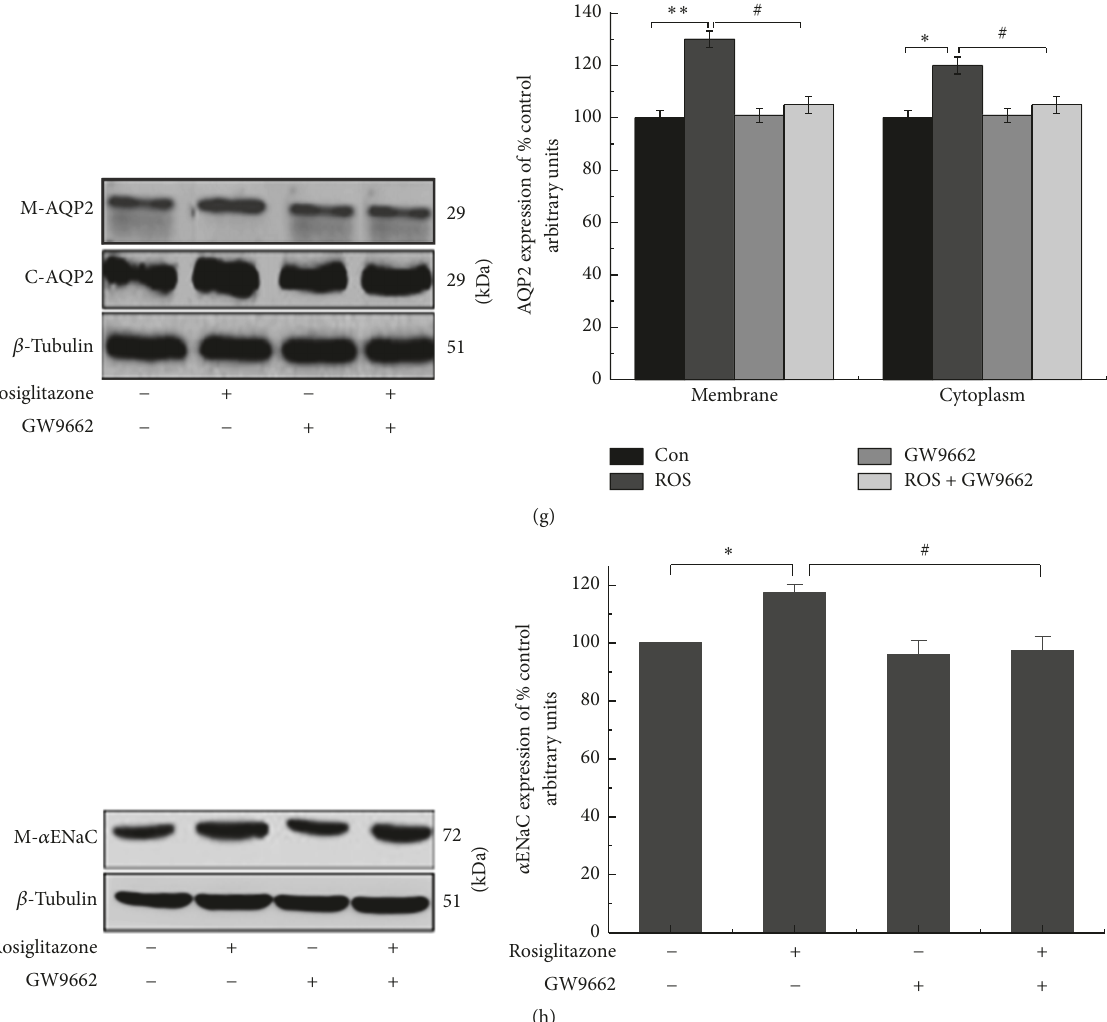
Figure 3: Effects of rosiglitazone and coincubation with GW9662 in HEK293 cells. (a–d) The effects of rosiglitazone on PPAR 𝛾 , p-PPAR 𝛾 , AQP2, and 𝛼 ENaC. (e–h) The changes of PPAR 𝛾 , p-PPAR 𝛾 , AQP2, and 𝛼 ENaC upon coincubation with GW9662 (10 𝜇 M ROS + 5 𝜇 M GW9662). The results show that rosiglitazone at 10 𝜇 M can significantly decrease total and nuclear p-PPAR 𝛾 but critically upregulated nuclear PPAR 𝛾 and AQP2 and 𝛼 ENaC membrane transposition. After coincubation with GW9662 (10 𝜇 M ROS + 5 𝜇 M GW9662), the effects of rosiglitazone on PPAR 𝛾 , p-PPAR 𝛾 , AQP2, and 𝛼 ENaC disappeared. The results are shown as mean ± s.e.m., 𝑛 = 3 . ∗/ # 𝑃 < 0.05 . ∗∗/ ## 𝑃 < 0.01 . ∗ means compared to control; # means compared to